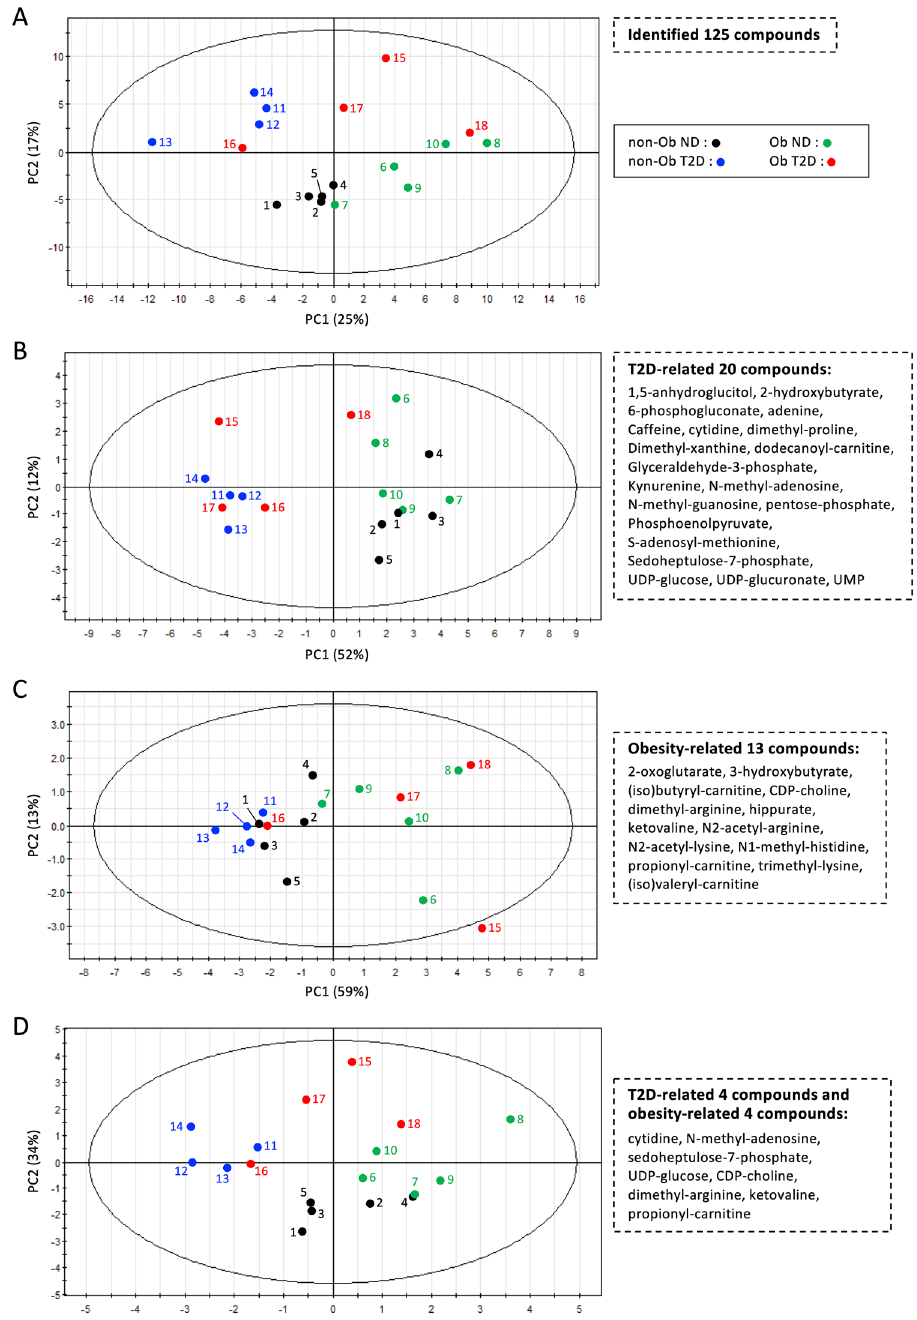
Figure 5. PCA plots of T2D and obesity-related compounds. ( A ) All 125 compounds identified in the present study roughly divided the T2D and ND groups. ( B ) Twenty diabetic markers separated ND and T2D subjects, except one subject (no. 18). ( C ) Thirteen obesity markers largely separated non-Ob and Ob subjects. ( D ) Even eight metabolites separated four subject groups, Ob T2D, non-Ob ND, non-Ob T2D, and Ob ND, to up, down, left, and right sides,